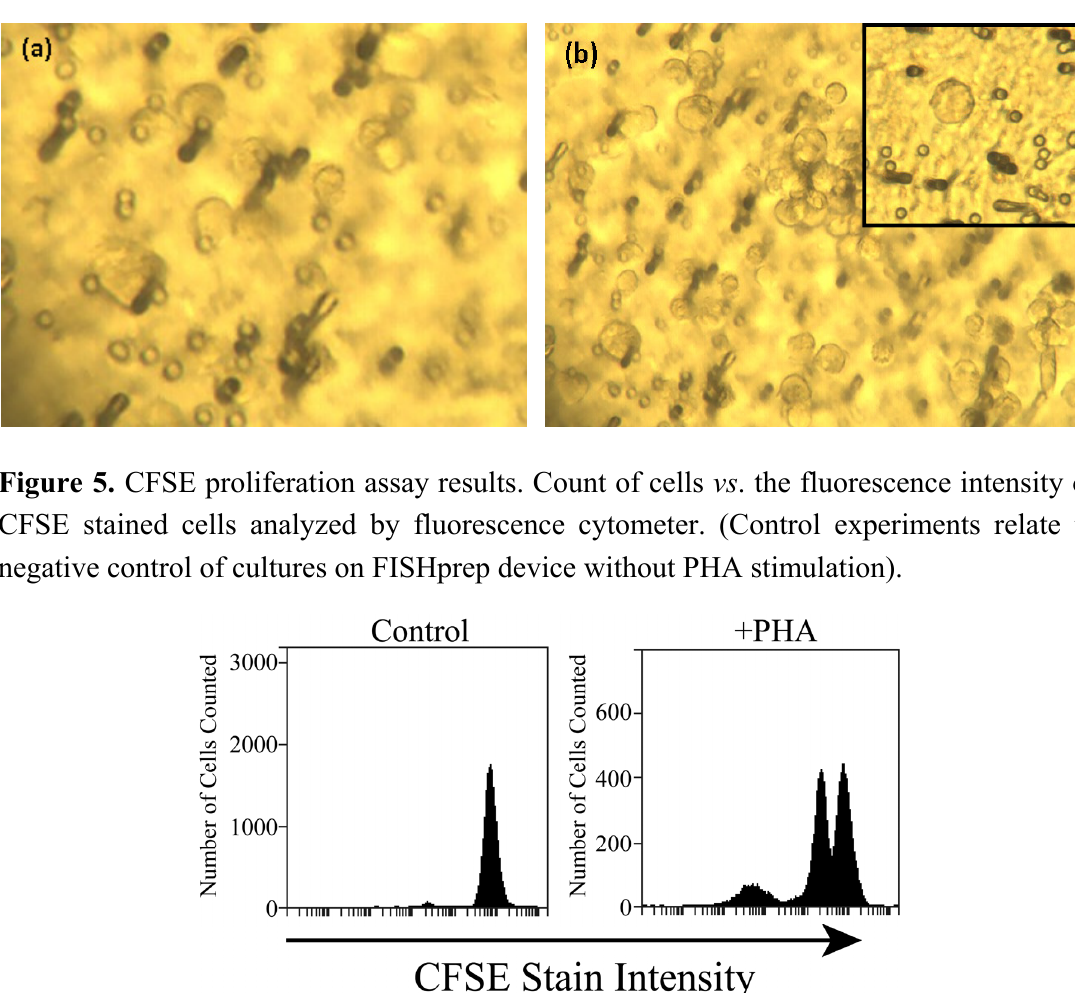
Figure 4. FISHprep culture (a) Cells on Day 0 (b) : Cells on Day 3 (Background shows pores in the PC membrane). (Inset—Enlarged cytoplasm on Day 3).